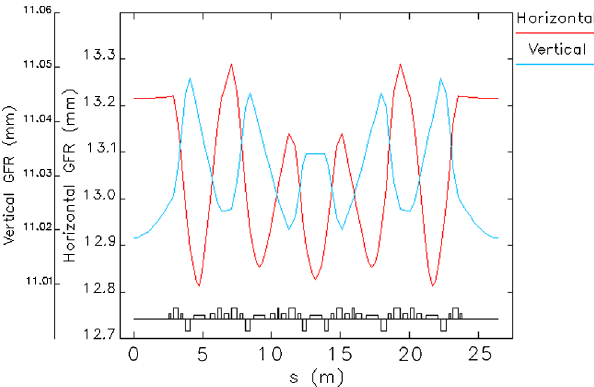
FIG. 12. The good field region in a super period of the storage ring. (cid:3) 4% energy error is assumed.